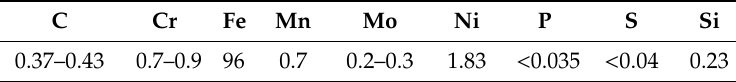
Table 1. AISI 4340 steel chemical composition as a percentage.